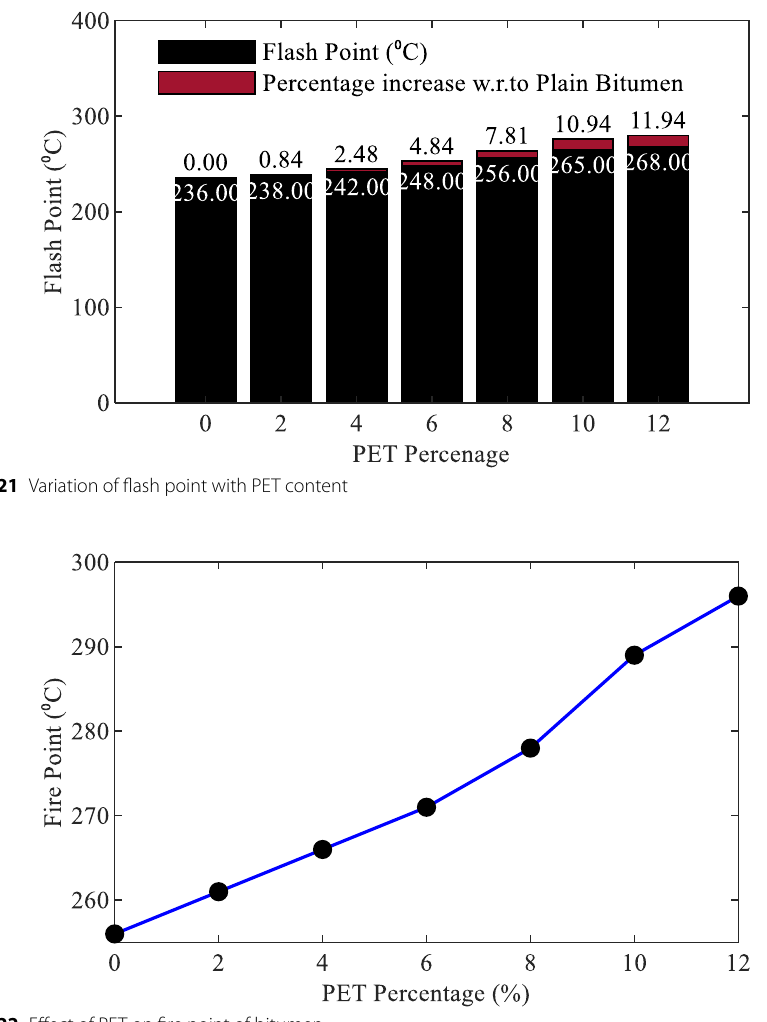
Fig. 22 Effect of PET on fire point of